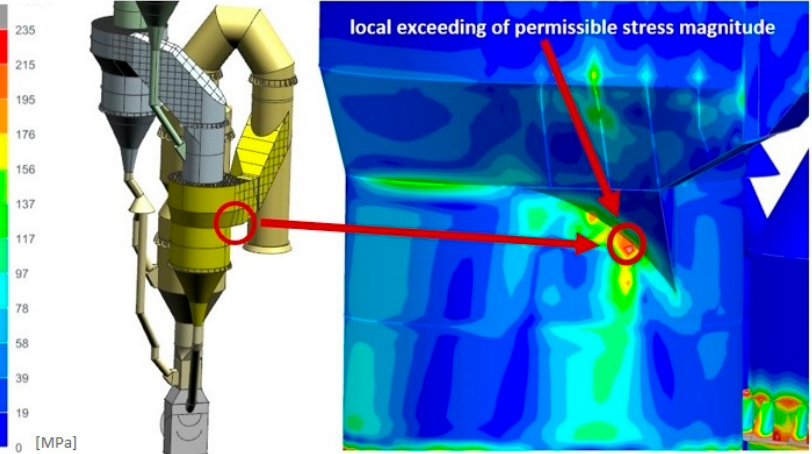
Figure 17. The stress pattern for the analysis accounting measured hotspots, von Mises stresses. The locations of this region is the area where the cylindrical part of the structure connects with the material transportation channel. At this place, the geometry changes significantly.